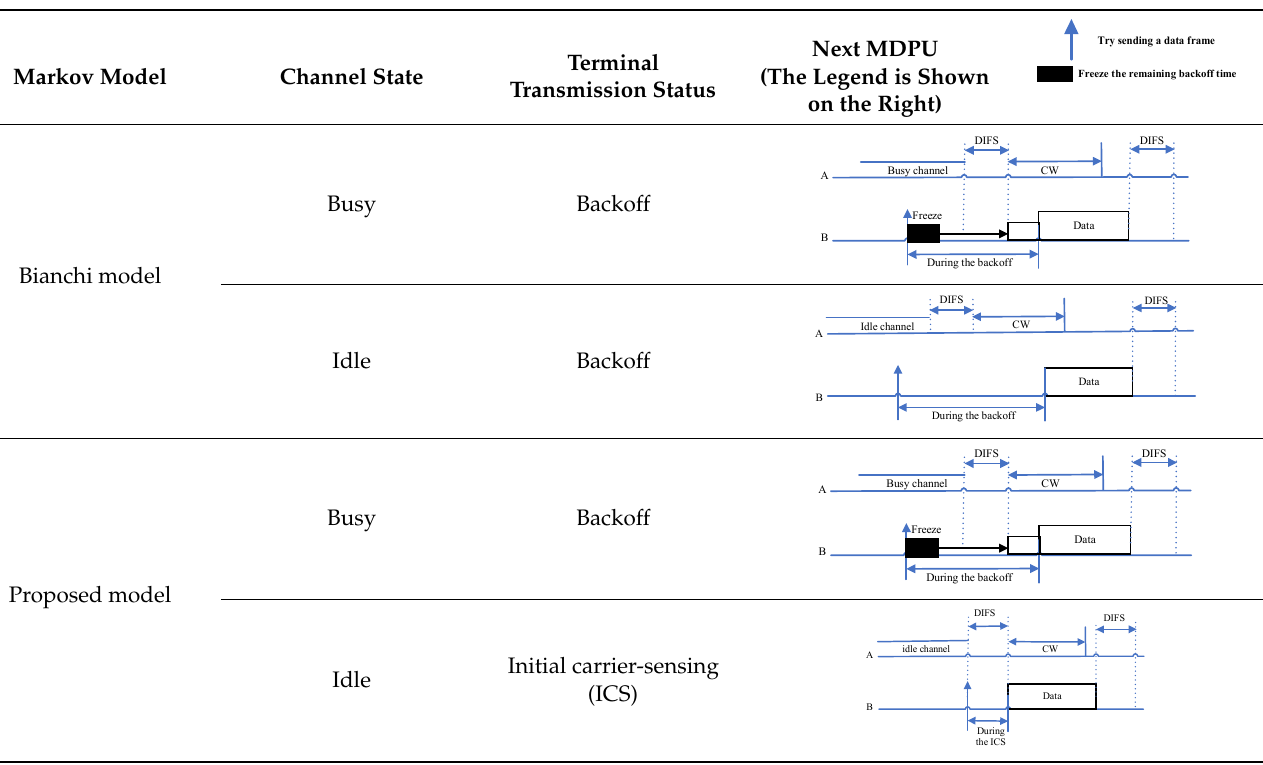
Table 1. Comparison of transmission procedure between Bianchi model and proposed model in the 802.11 DCF protocol.